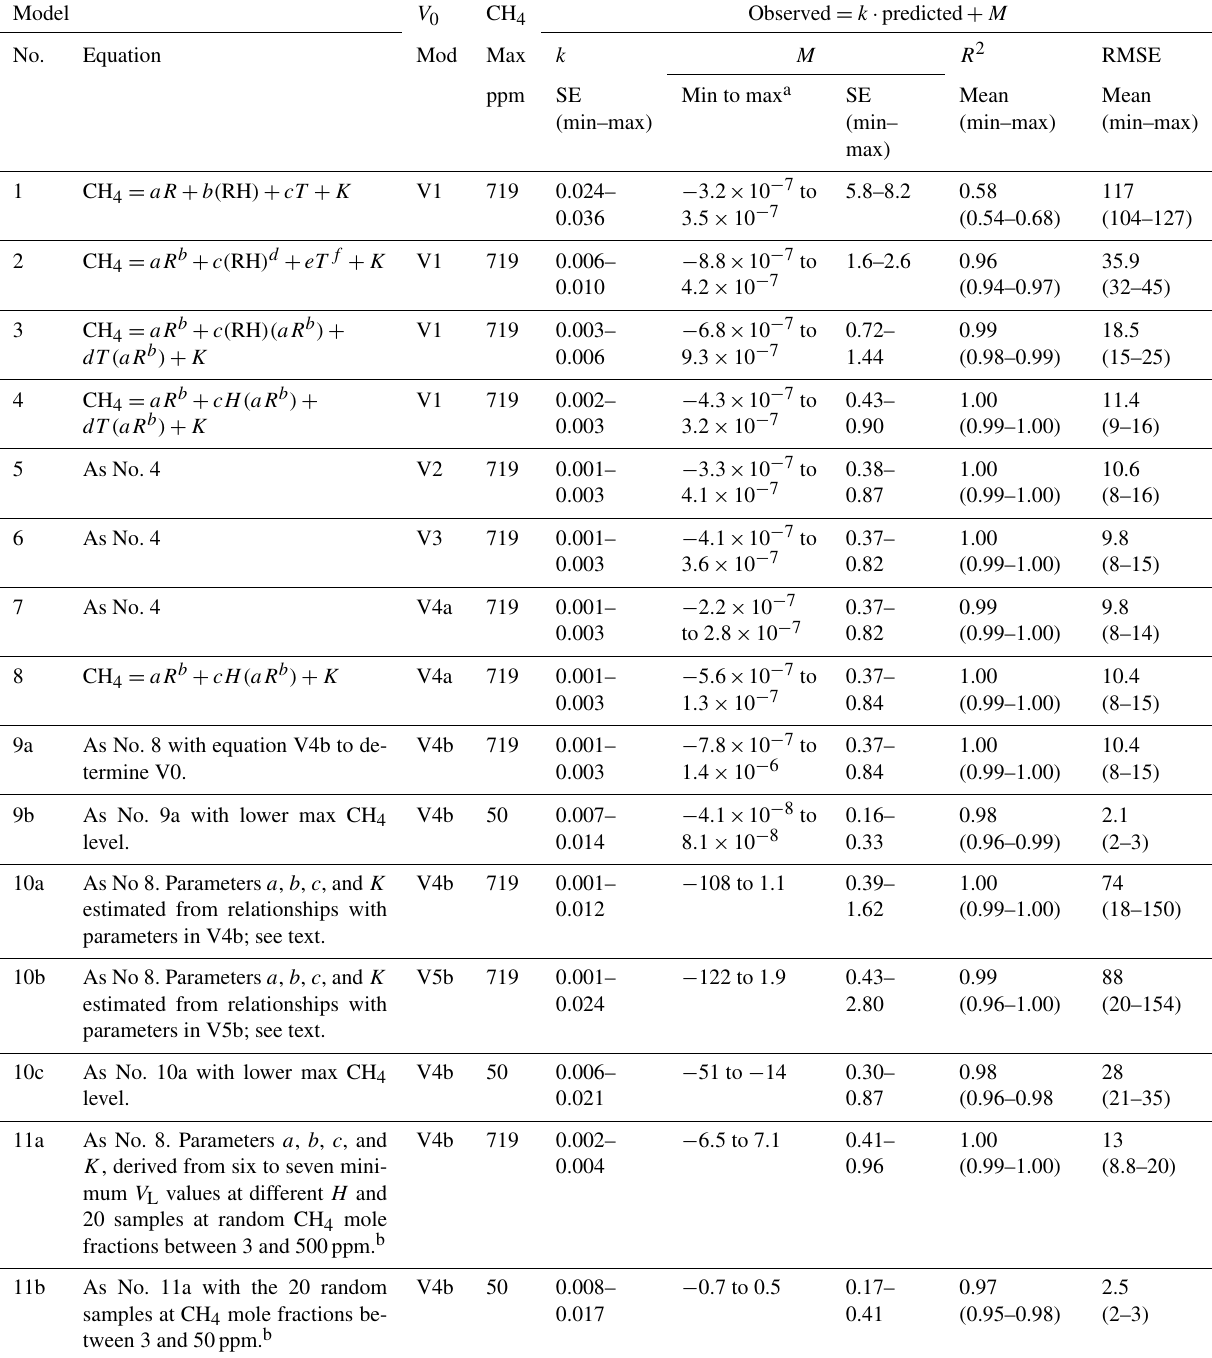
Table 2. Model results for Step 2 of the data evaluation, i.e., the determination of methane (CH 4 ) mole fractions (ppm) from the sensor response expressed as R (corresponding to R S /R 0 ) using different calibration models. (RH), H , and T as defined in Table 1. The model parameters a , b , c , d , e , f , and K are constants for each sensor derived by curve fitting. The models were evaluated via a linear regression of observed versus predicted CH 4 mole fractions, where k and M are the slope and the intercept, respectively. SE denotes standard error, R 2 the adjusted coefficient of determination (mean and minimum to maximum for the 20 sensors tested), and RMSE the root-mean-square error (ppm). The table shows the most successful subset of all models tested. N = 619–930 per sensor in total and 203–313 for the data subset with CH 4 mole fractions < 50ppm. See text for